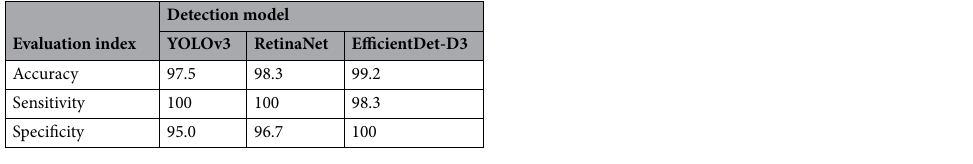
Table 2. Accuracy, sensitivity, and specificity of the three models